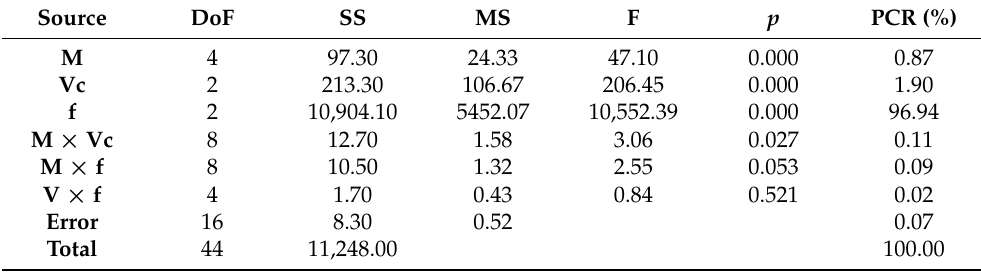
Table 3. ANOVA for thrust